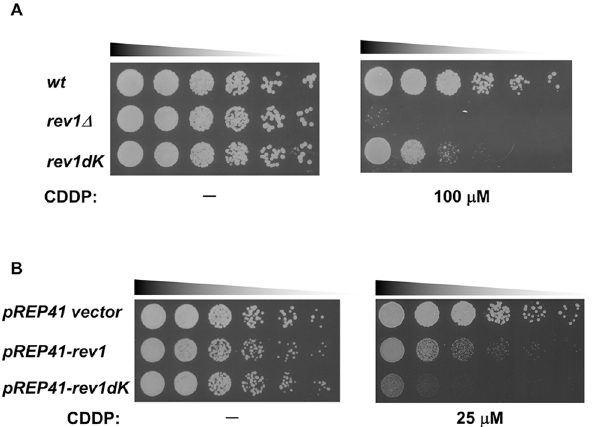
Fig 6. Increased expression of Rev1 sensitized the cells to cisplatin. A, rev1dK exhibited cisplatin (CDDP) sensitivity. wt, rev1 Δ , and rev1dK strains were grown. Cells were spotted on YES plates containing cisplatin with 5-fold serial dilutions, and the plates were incubated at 30°C for 3 days. The panels represent the growth of wt, rev1 Δ , and rev1dK strains on cisplatin minus control and on a YES plate containing 100 μ M cisplatin. B, Overexpression of rev1 conferred sensitivity to cisplatin. Cells harboring pREP41, pREP41- rev1 , or pREP41- rev1dK plasmids were grown in EMM media without thiamine and spotted on an EMM plate containing 0 or 25 μ M CDDP with 5-fold serial dilutions. The plates were incubated at 30°C for 3 days. The panels represent the growth on an EMM plate without CDDP or containing 25 μ M